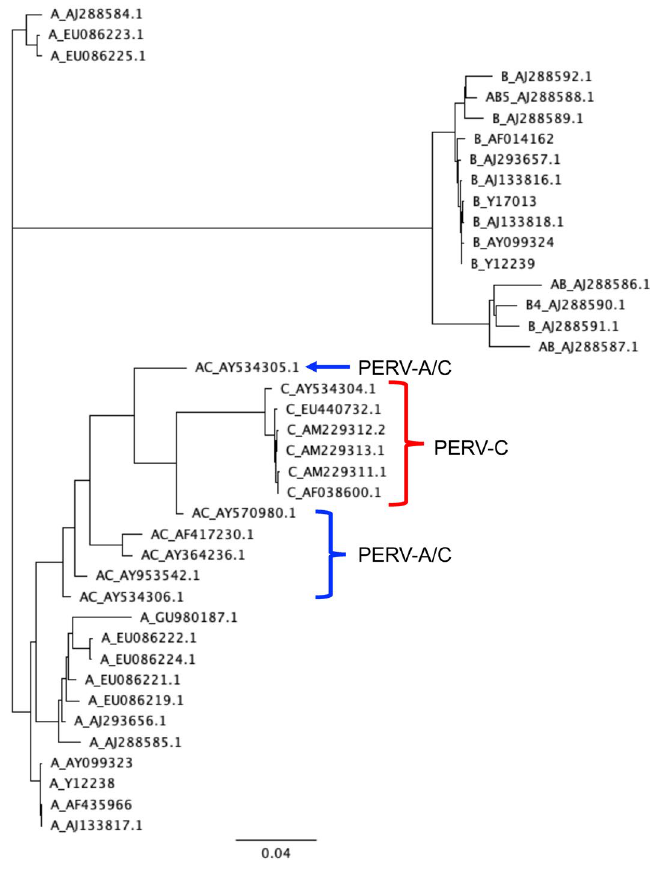
Figure 1. A phylogenetic tree of PERV subgroups. PERV env sequences obtained from the NCBI GenBank were multiple aligned, and obtained alignment data were used to create the phylogenetic tree using the neighbor-joining